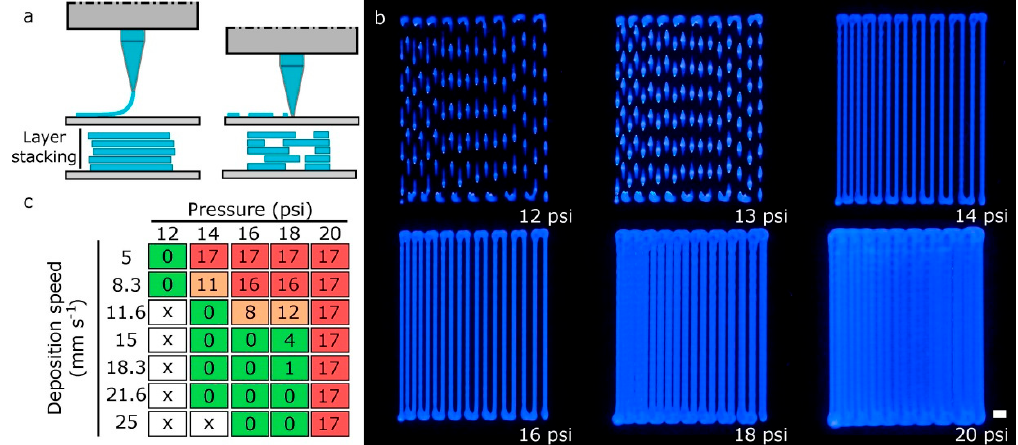
Figure 8. ( a ) scheme of the possible defects in the first layer calibration: nozzle too far from printing platform and nozzle too close to printing platform; ( b ) images of the zigzag path calibration models printed at a deposition speed of 15 mm s − 1 for various printing pressures; scale bar: 1 mm; ( c ) quantification of the number of filled spaces between strands in the calibration model 2 varying printing pressure and deposition speed (green: good; orange: normal; red: bad; x: discontinuous printing).